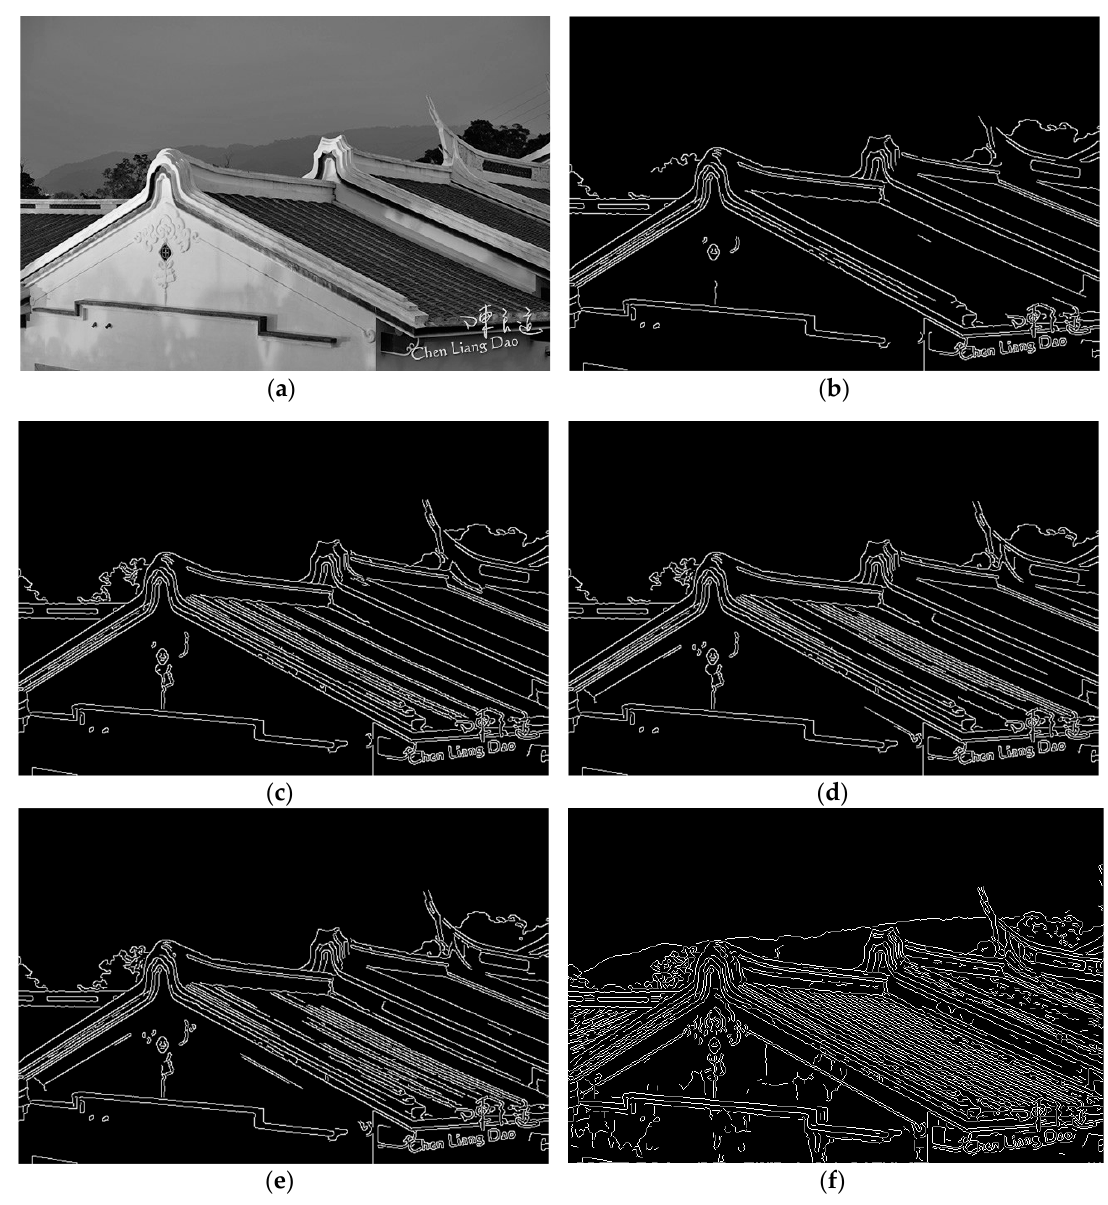
Figure 16. Embossed tile image comparison results of different methods. ( a ) Original image (640 × 480) [21]; ( b ) Gao and Liu’s method (TH H = 238, TH L = 119); ( c ) Song et al. proposed method (TH H = 238, TH L = 20); ( d ) Saheba et al.’s method (TH H = 102, TH L = 31); ( e ) Li and Zhang’s method (TH H = 74, TH L = 29); ( f ) TCEDA.